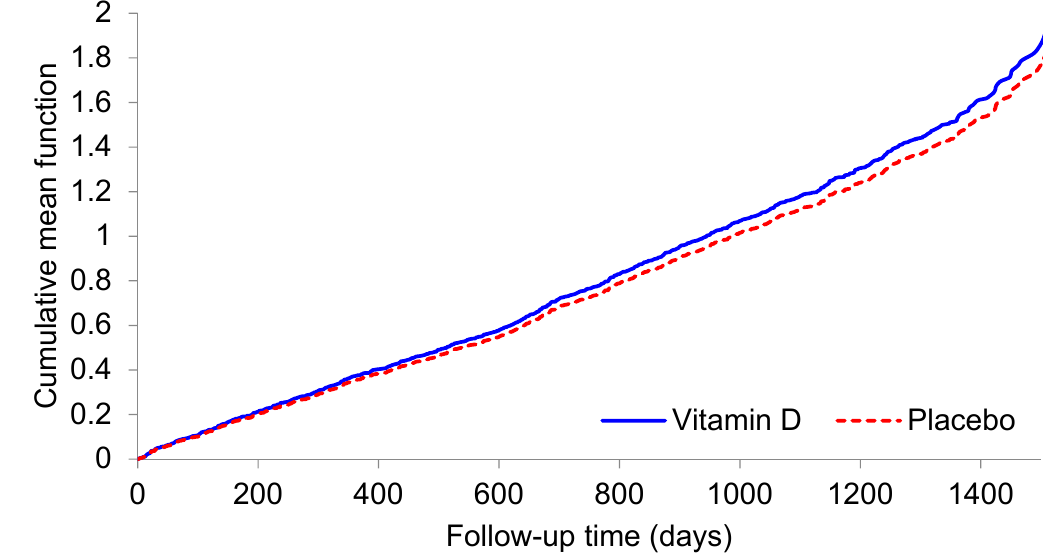
Figure 2. Mean cumulative number of exacerbations of asthma or chronic obstructive pulmonary disease during follow-up to 31 July 2015, by study treatment.